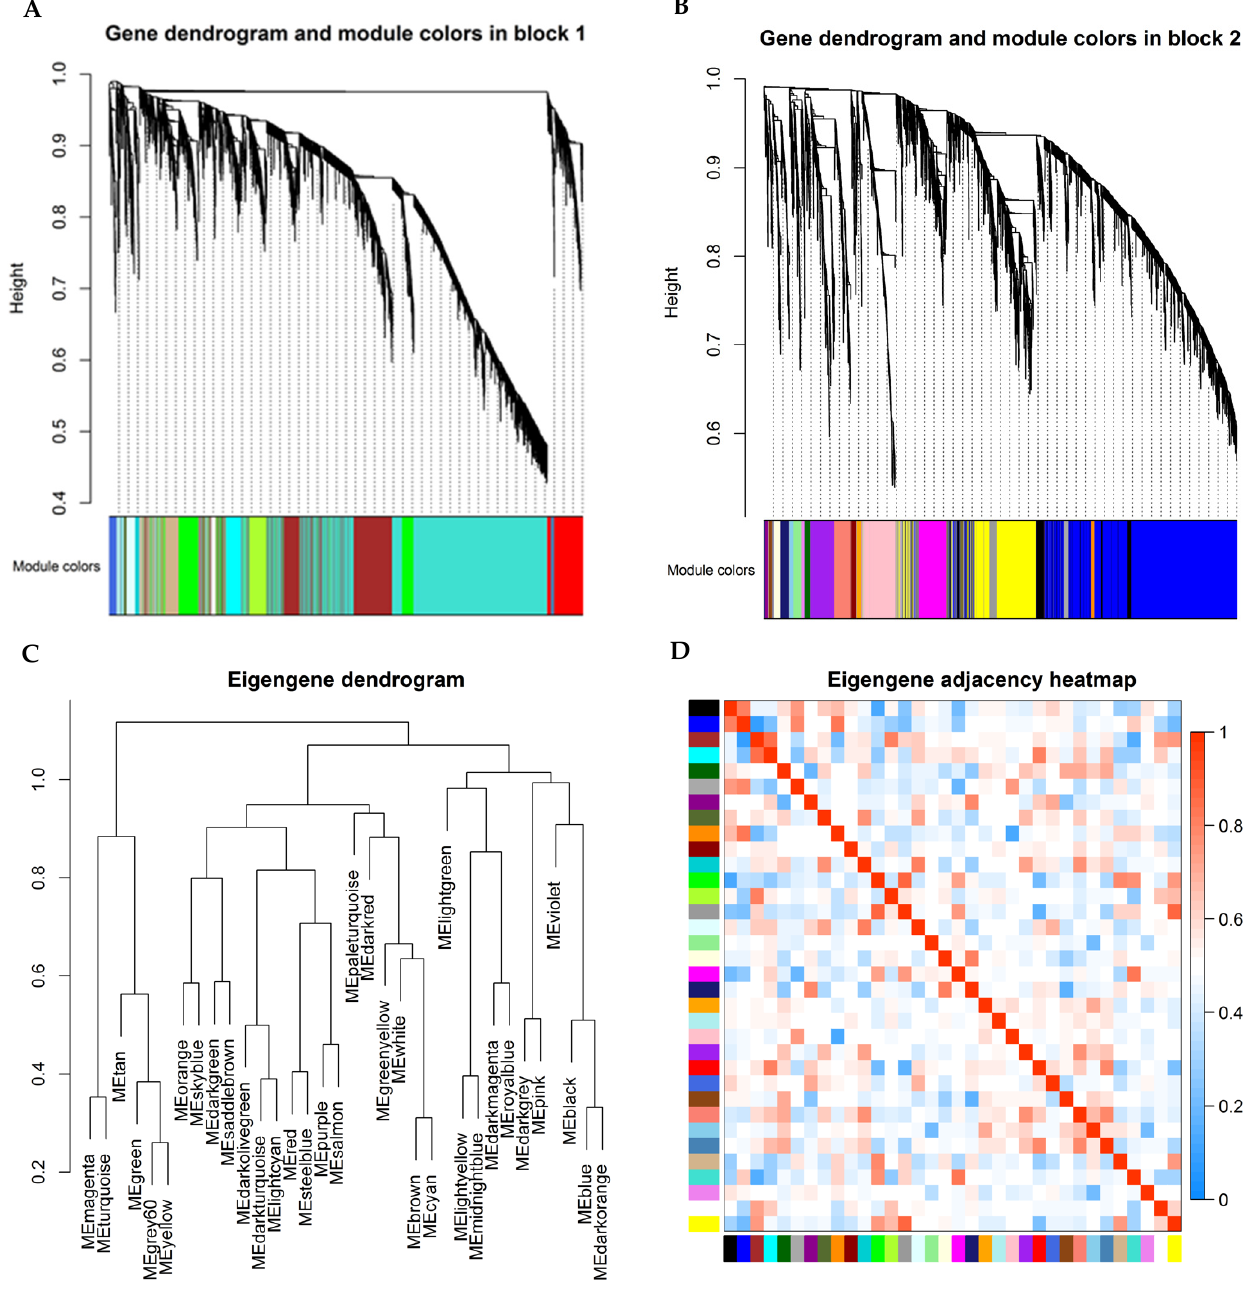
Figure 1. Module detection and network heatmap plot construction using WGCNA in the training group. Each colored row represents a color-coded module that contains a group of highly connected genes. ( A , B ) Dendrogram obtained by hierarchical clustering of genes based on their topological overlap is shown at the top; ( C ) Dendrogram of module eigengenes obtained from WGCNA on the correlation; ( D ) Module eigengene adjacency heatmap (each colored row in x- or y-axis represents a color-coded